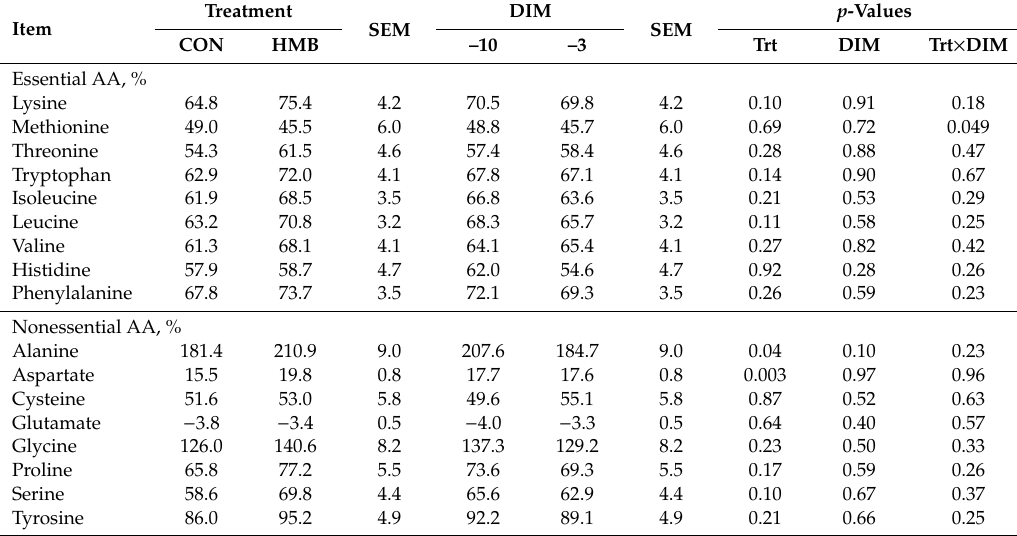
Figure 3. Net portal fluxes of HMB ( A ), glucose ( B ), insulin ( C ), Lys ( D ), Leu ( E ), Ile ( F ), Val ( G ), portal flow ( H ), and net portal flux of O 2 ( I ) in control (CON) and HMB-supplemented (HMB) sows during late gestation. Data are expressed as the mean ± SEM. Sows were regarded as the experimental units, n = 4 for each group. Interaction of treatment and sampling time after feeding were observed for net portal fluxes of HMB ( p < 0.001), glucose ( p < 0.001), insulin ( p < 0.001), Lys ( p = 0.004), Leu ( p < 0.001), Ile ( p < 0.001), Val ( p = 0.001), portal flow ( p = 0.03), and O 2 ( p = 0.04), respectively. CON = control; HMB = β -hydroxy- β -methyl butyrate. Table 5. Net portal recovery of amino acids in control (CON) and HMB-supplemented (HMB) sows during late gestation. Treatment Item